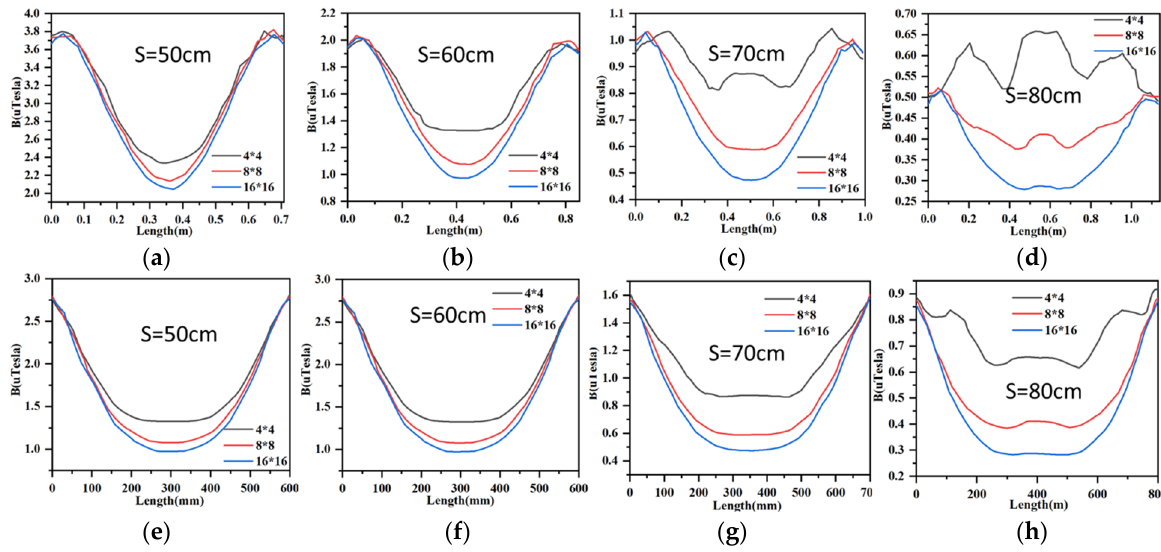
Figure 11. Magnetic induction intensity of mesh aluminium plate electromagnetic shielding: ( a ) 50 cm in transverse direction; ( b ) 60 cm in transverse direction; ( c ) 70 cm in transverse direction; ( d ) 80 cm in transverse direction; ( e ) 50 cm in diagonal direction; ( f ) 60 cm in diagonal direction; ( g ) 70 cm in diagonal direction; ( h ) The diagonal direction 80 cm.